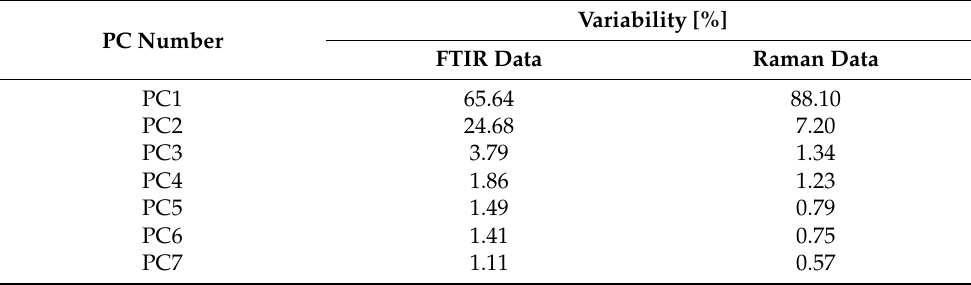
Table 5. Variability explained by the principal components (PCs) obtained by decomposition of the spectral data (red grape seeds extracts) using principal component analysis